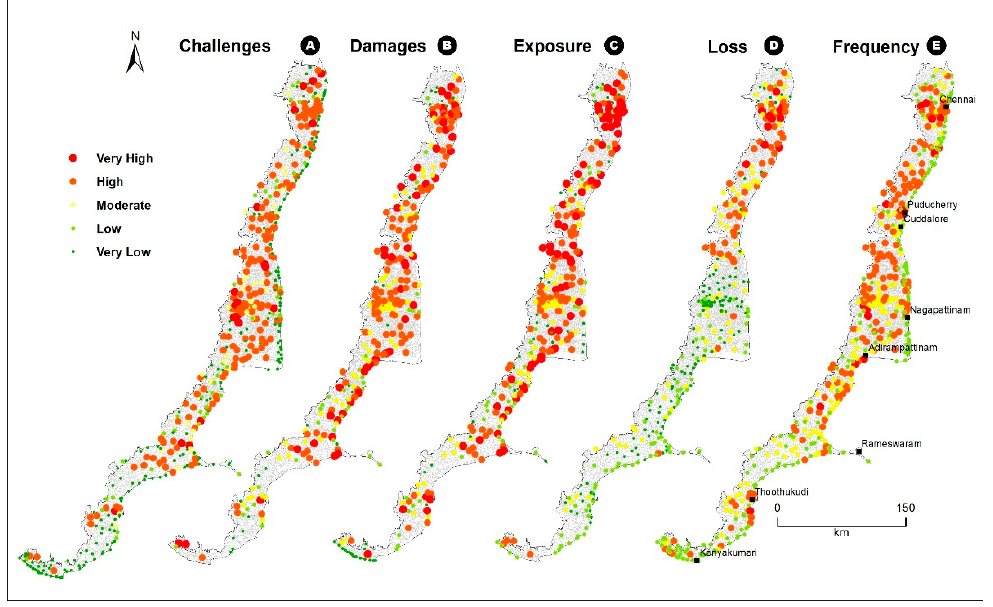
Figure 8. Spatial distribution of perceptions on ( A ) flood challenges, ( B ) flood damage, ( C ) flood exposure, ( D ) flood loss, and ( E ) flood frequency.